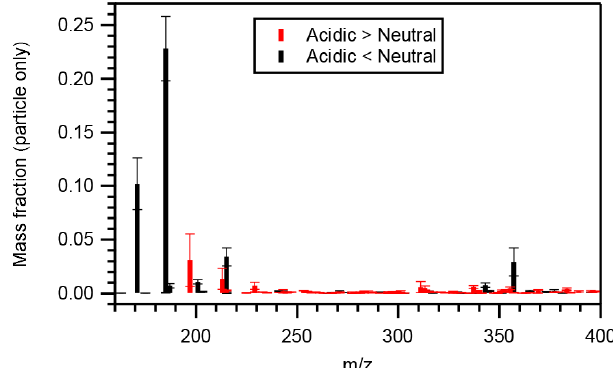
Figure 5. Mean particle-phase mass fraction distributions of com- pounds whose particle-phase mass fractions under acidic seed con- ditions were more than 1.1 (red symbols) or less than 0.9 (black symbols) times those of neutral seed conditions. Whiskers repre- sent the standard deviations of the three experiments at different temperatures.